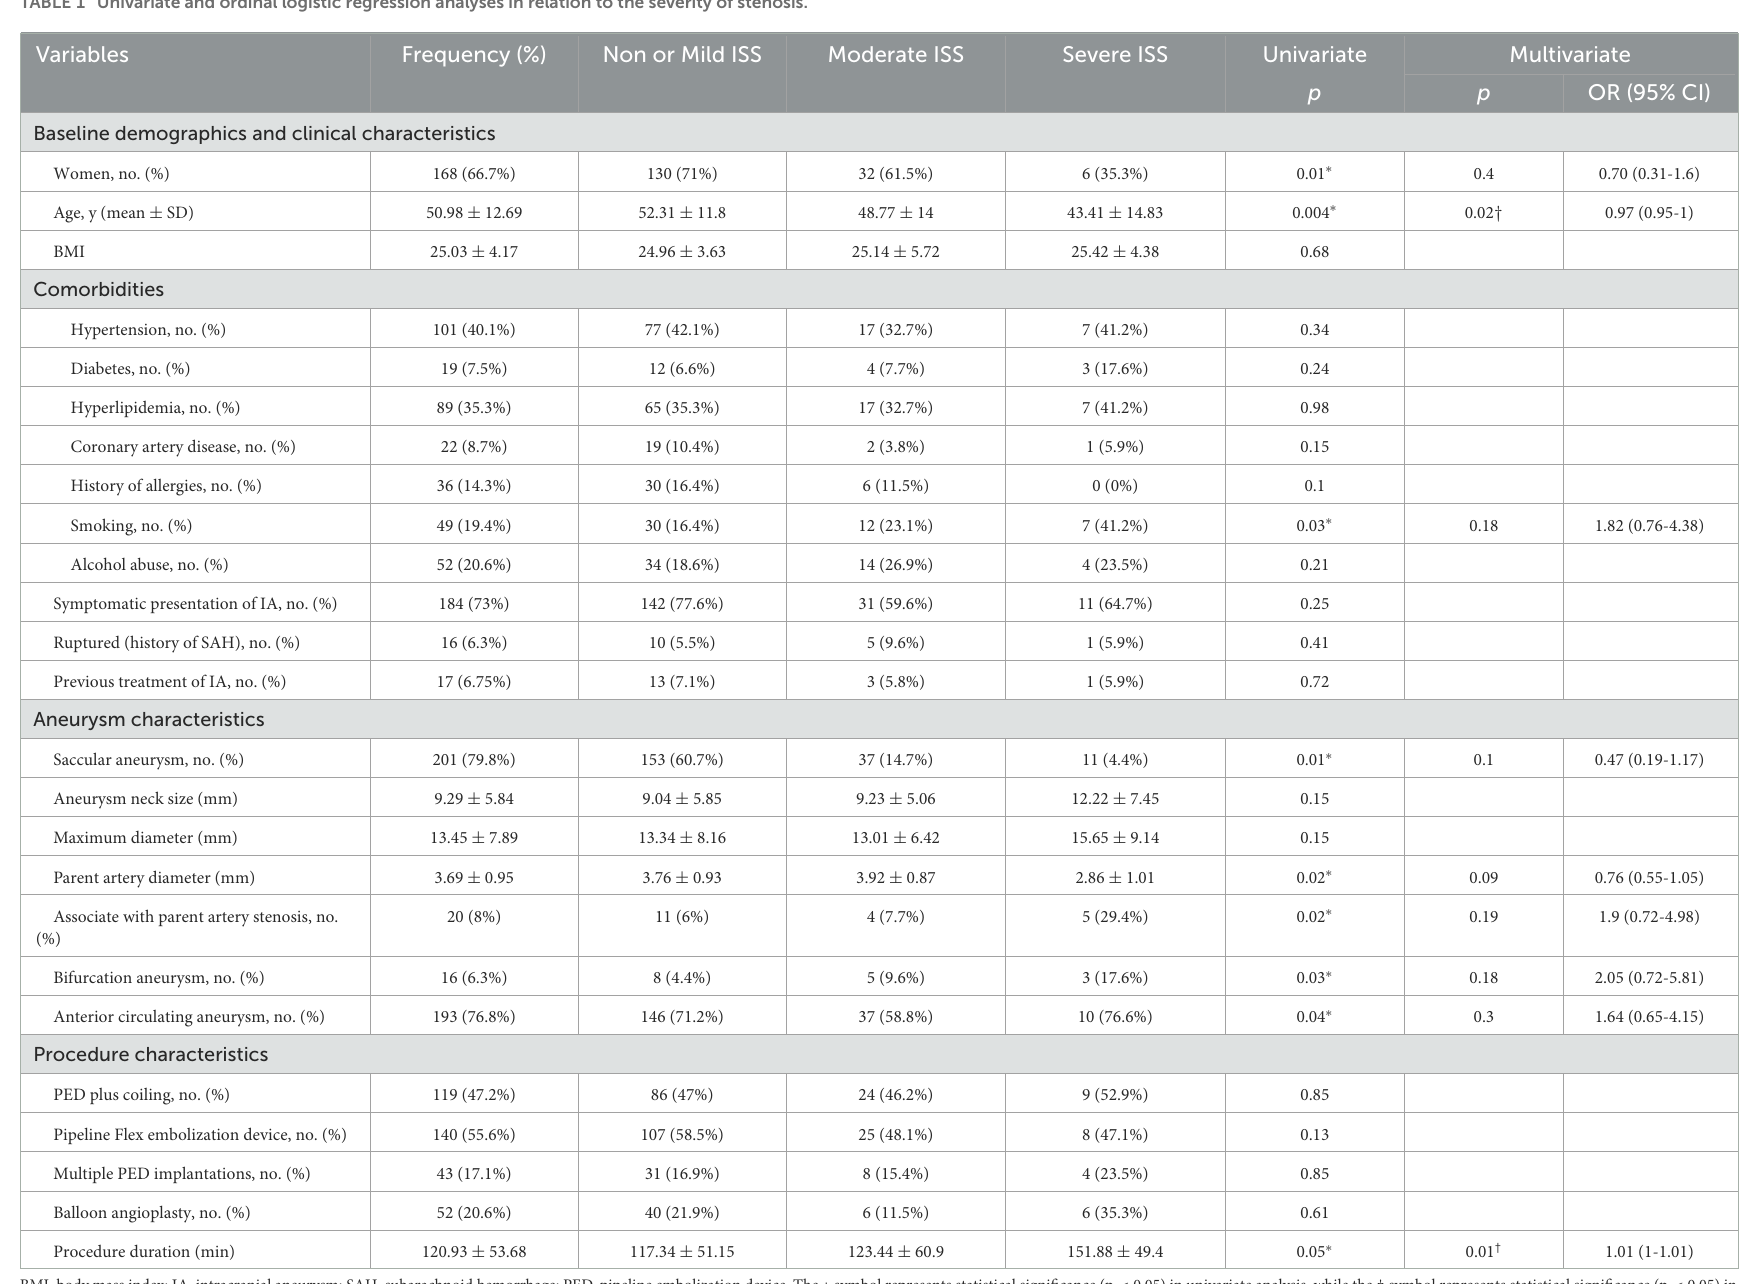
TABLE 1 Univariate and ordinal logistic regression analyses in relation to the severity of stenosis. Variables Frequency (%) Non or Mild ISS Moderate ISS Severe ISS Univariate Multivariate Baseline demographics and clinical